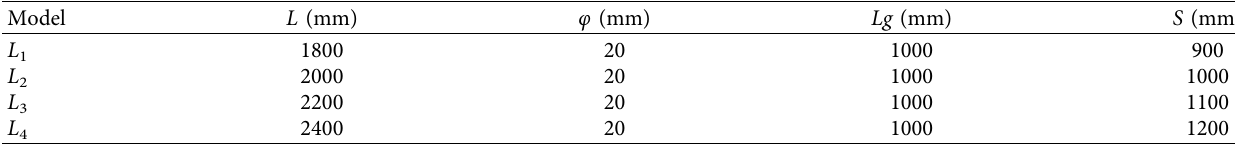
Table 4: Model design with different bolt lengths.